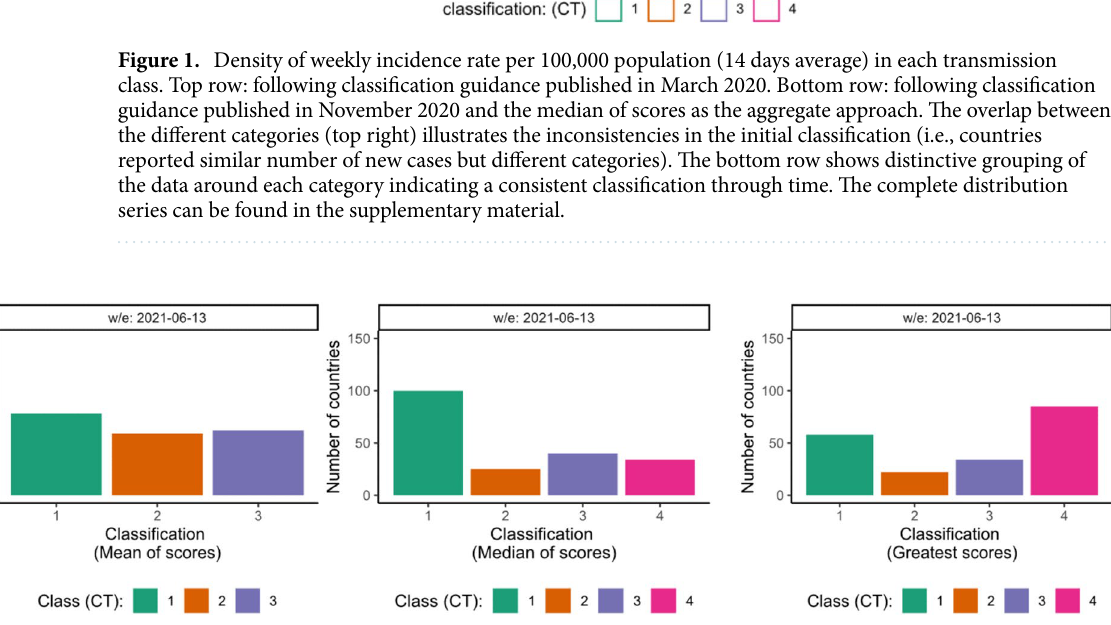
Figure 2. Frequency of country distribution according to the aggregate approach for the new classification guidelines published in November 2020. Left: Mean of scores. Centre: Median of scores. Right: Greatest of the scores. The complete distribution can be found in the supplementary